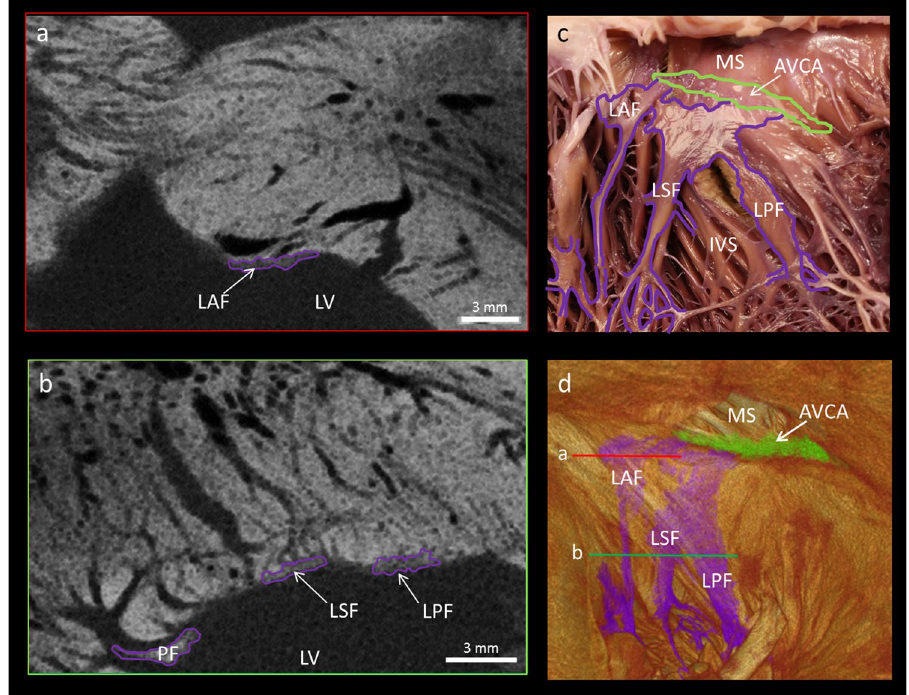
Figure 5. The fascicular arrangement of the left bundle branch resolved by micro-CT. This figure demonstrates high resolution (73 × 73 × 73 µ m 3 ) micro-CT data from a whole human heart. Panels a and b show short axis micro-CT sections of the ribbon-like anterior, septal and posterior fascicles in the planes indicated in the 3D segmentation ( d ). A comparison between the visual anatomy in a macro photograph and the segmented atrioventricular conduction axis and left sided bundle branches of the same heart is shown in panels c and d. AVCA- atrioventricular conduction axis, IVS- interventricular septum, LV- left ventricular cavity, LAF- left anterior fascicle, LSF- left septal fascicle, LPF, left posterior fascicle, MS- membranous septum, PF- Purkinje